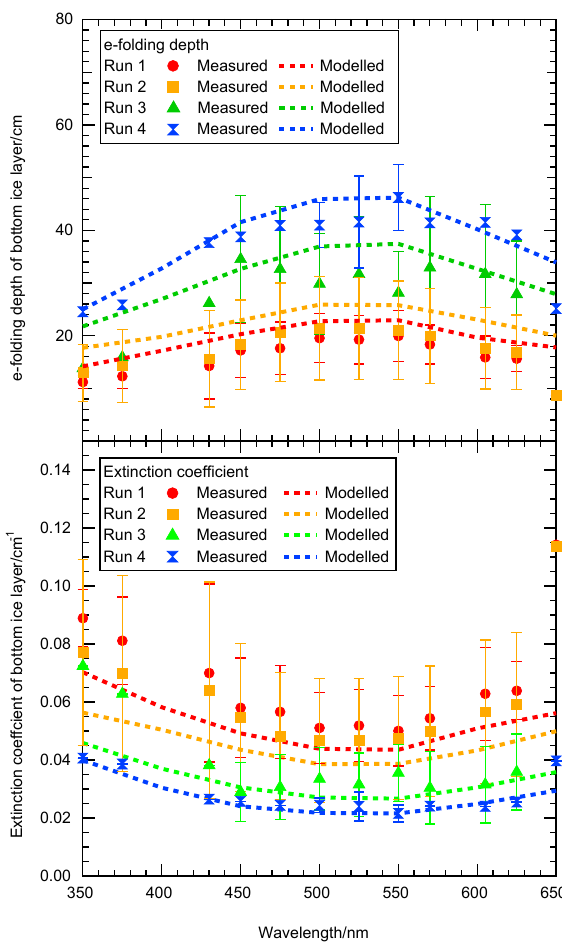
Figure 8. Top: measured sea ice e -folding depth versus wave- length (solid shapes) and modelled sea ice e -folding depth versus wavelength (dashed lines) for sea ice with no added black carbon. Bottom: measured sea ice extinction coefficient versus wavelength (solid shapes) and modelled sea ice extinction coefficient versus wavelength (dashed lines).